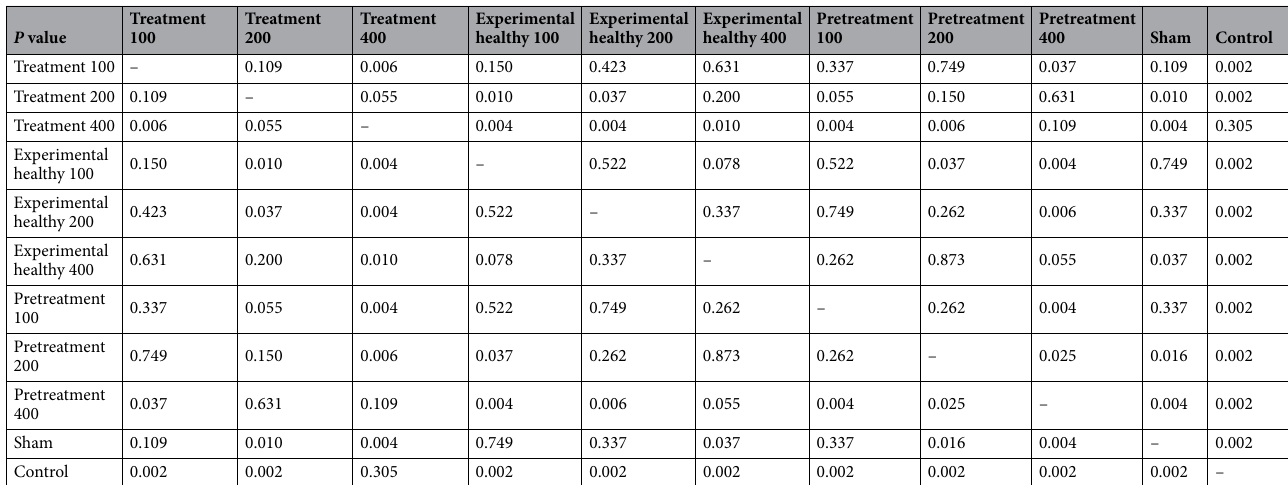
Table 3. Pairwise comparison of Ins1 expression between groups based on Mann–Whitney Test. The gene expression was calculated based on fold change by. ΔCt = Ct (target gene) − Ct (Housekeeping